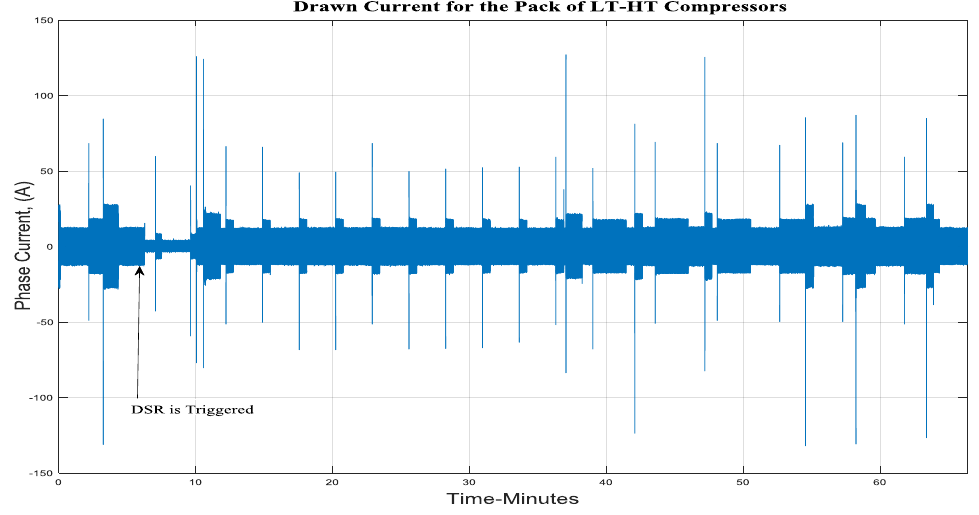
Figure 10. One phase drawn current for the 3Ø refrigeration pack system before and after DSR.